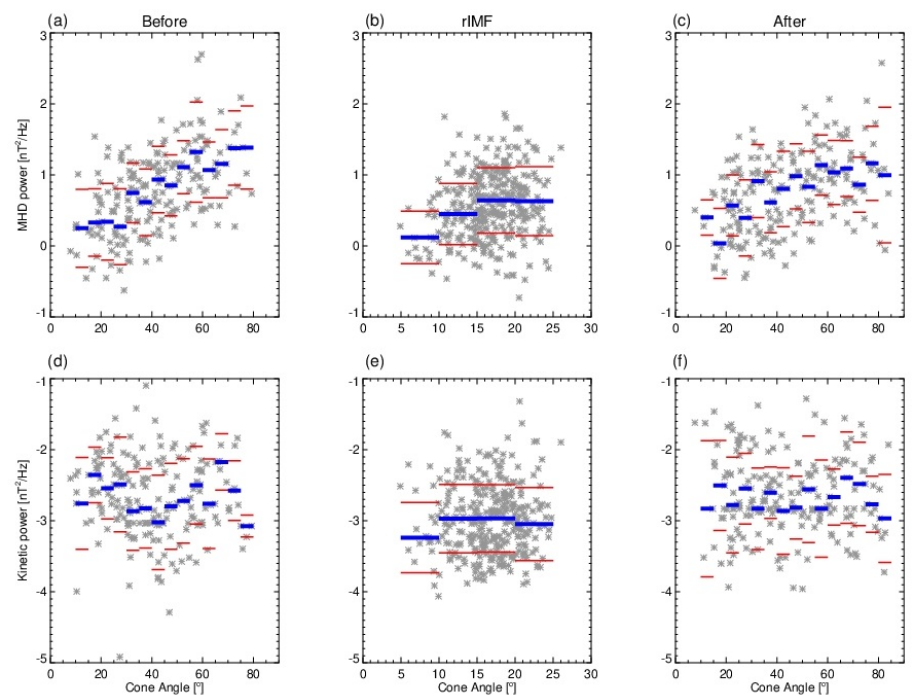
Figure 9. Scatter plots of the PSD power as a function of the cone angle ( a ) in the region before the radial IMF events, ( b ) in the radial IMF events, and ( c ) after the events in the MHD ranges and the same plots ( d ) in the region before the radial IMF events, ( e ) in the radial IMF events, and ( f ) after the events in the kinetic ranges. The blue bars represent the median value in each 5° bin, and the red bars denote the standard deviation of each bin.